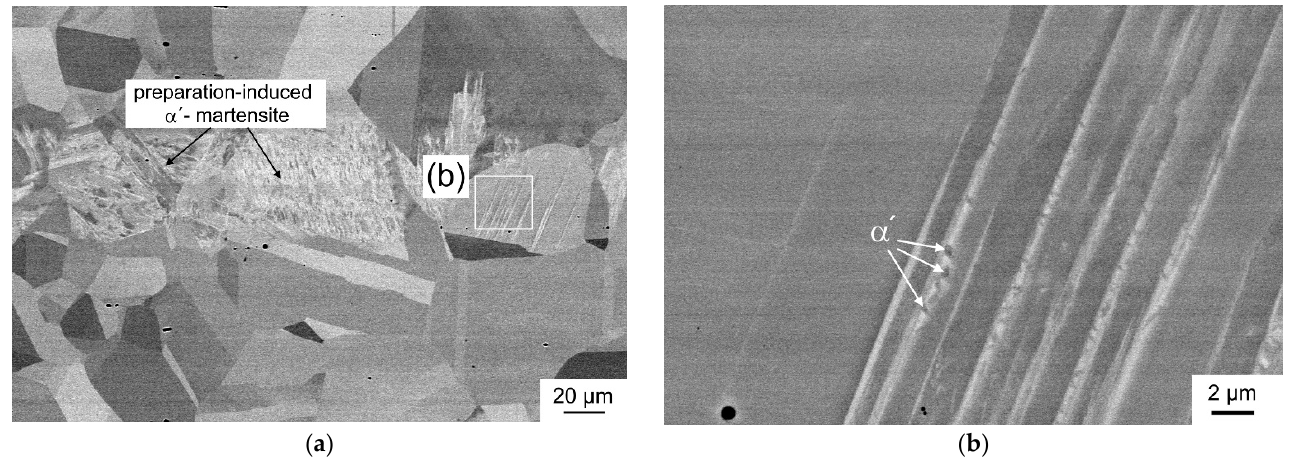
Figure 4. Microstructure of 0.2N steel in the threaded head after tensile test: ( a ) austenite grains with preparation-induced martensite and ( b ) detailed view of α ´-martensite platelets nucleated in single deformation bands. The tensile direction is horizontal in the plane of view.